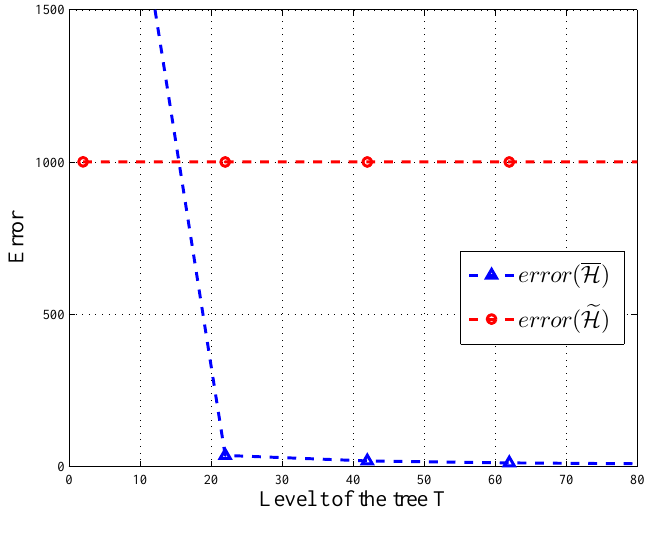
Figure 6. Error varies with the level.